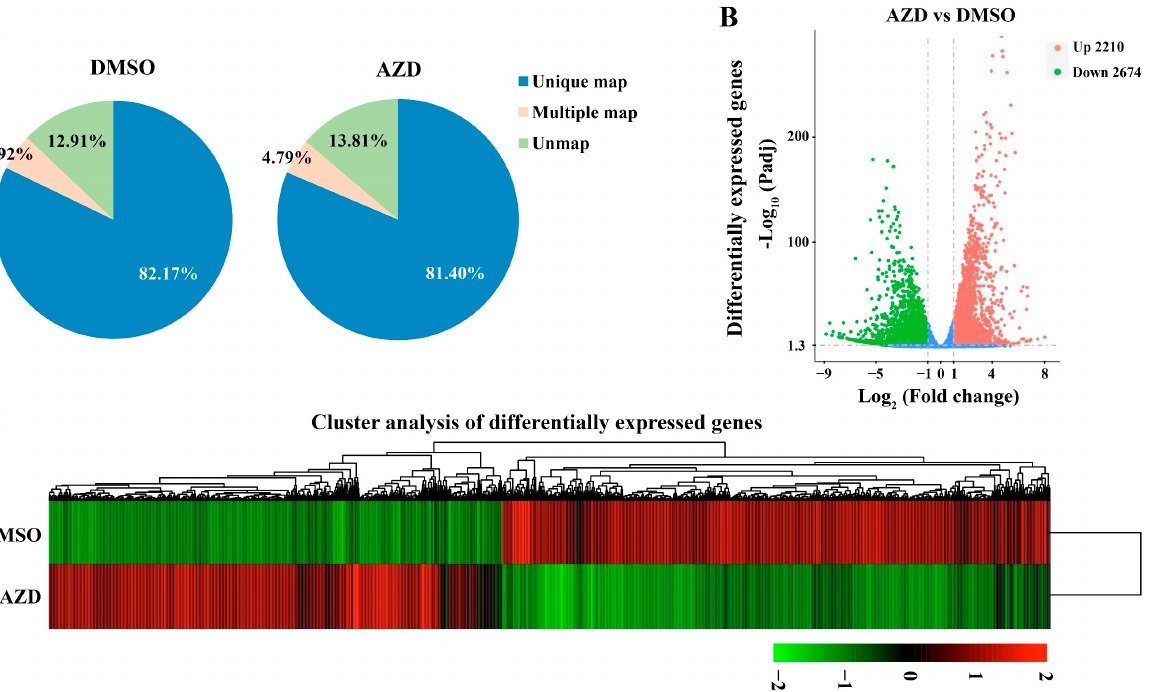
Figure 5. Transcriptome data analysis of Chlorella sorokiniana DP-1 under DMSO and AZD treatment. ( A ) Proportions of clean reads of unmapped, mapped to multiple genes and mapped to unique genes, which were plotted by three replicates of DMSO and AZD treatment. ( B ) The number of downregulated and upregulated differentially expressed genes for DMSO and AZD treatment. ( C ) Cluster analysis of differentially expressed genes for DMSO and AZD treatment. Red represents high gene abundance, and green represents low gene abundance.